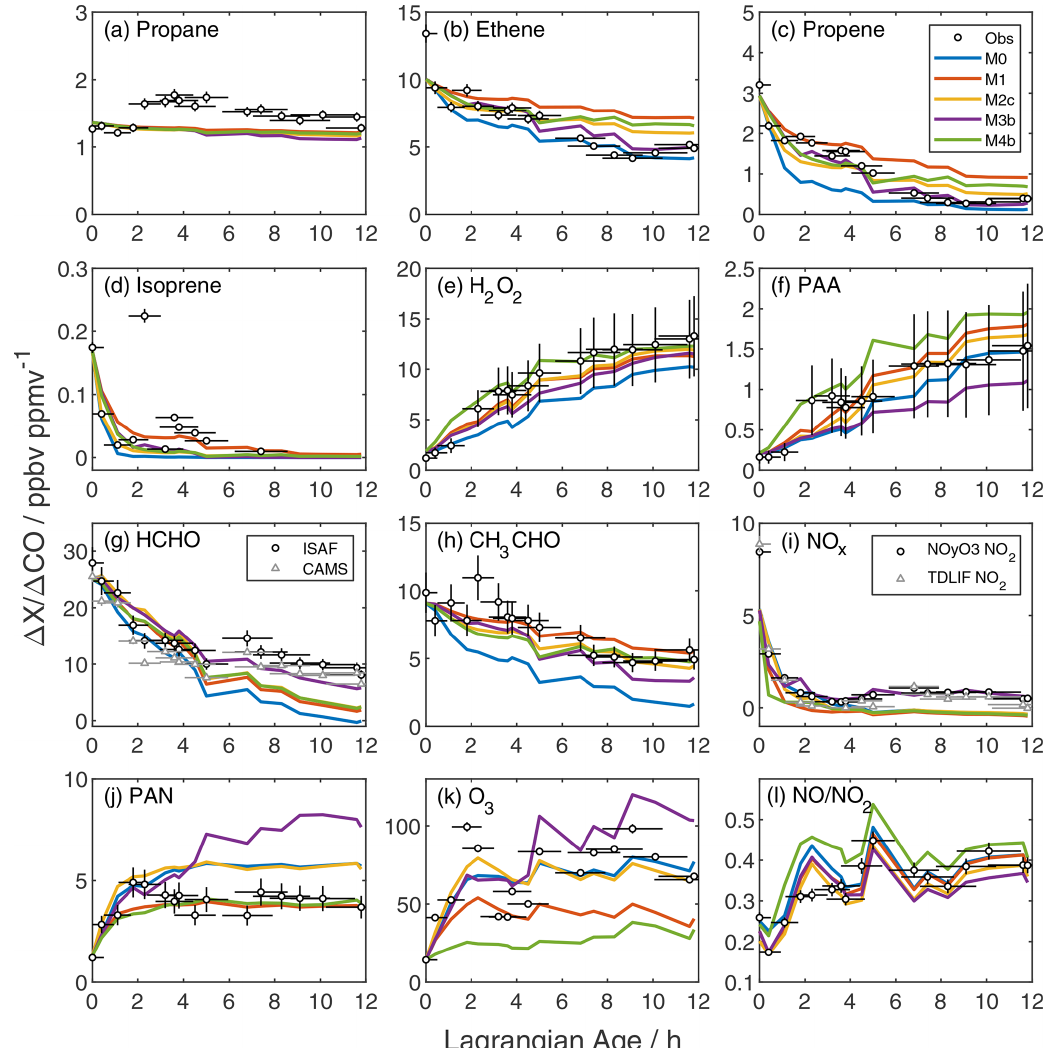
Figure 2. Age evolution of NEMRs for reactive gases (a–k) and the NO / NO 2 ratio (l) . Black circles are observations with their correspond- ing uncertainty due to measurement accuracy and age. Colored lines are the model output from the base simulation (M0; blue), addition of unmeasured VOC (M1; red), and addition of unmeasured VOC plus initial HONO (M2c; yellow), p NO − heterogeneous uptake (M4b; green). In panels (g) and (i) , circles and triangles represent two independent measurements of HCHO and NO 2 , respectively (Table S1). NO and NO 2 observations in panel (l) are from the NO y O 3